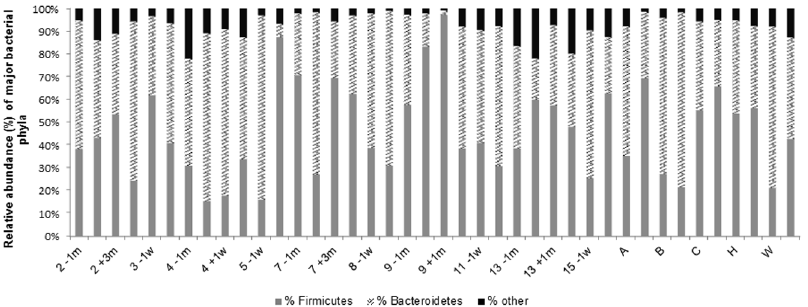
Figure 5. Relative abundance of Firmicutes and Bacteroidetes 16S rRNA sequences for all subjects’ samples analysed using high- throughput sequencing. Refer to Figure 1 legend for sample